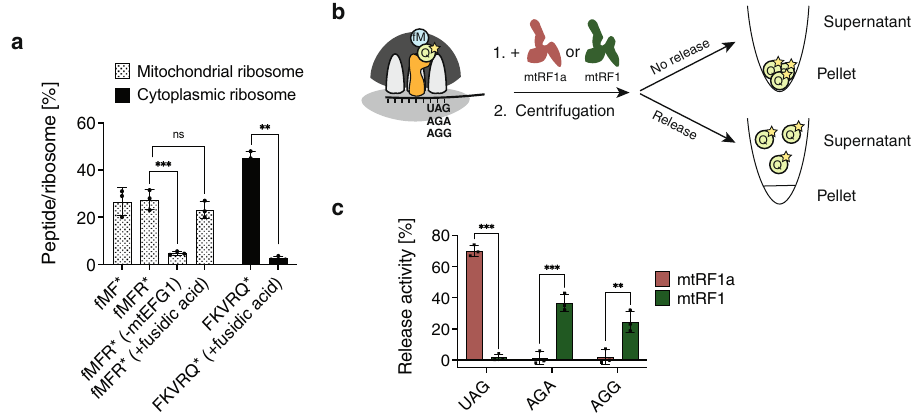
Fig. 5 | mtRF1 speci fi cally acts on non-canonical stop codons AGA/AGG. a In vitro translation assay using mitochondrial or cytosolic ribosomes. Up to fi ve amino-acylated tRNAs were added to the translation mixture. Elongation was assessed by measuring incorporation of radioactively labeled amino acids (*). Speci fi cityofmitoribosomaltranslationwastestedbytheabsenceofmtEFG1orby additionoffusidicacid.MeansandSDof n =3independentexperiments.Unpaired two-tailed t-test (* P <0.05; ** P <0.01; *** P <0.001; ns = not signi fi cant). Only rele- vant statistics are highlighted. b Schematic representation of the in vitro